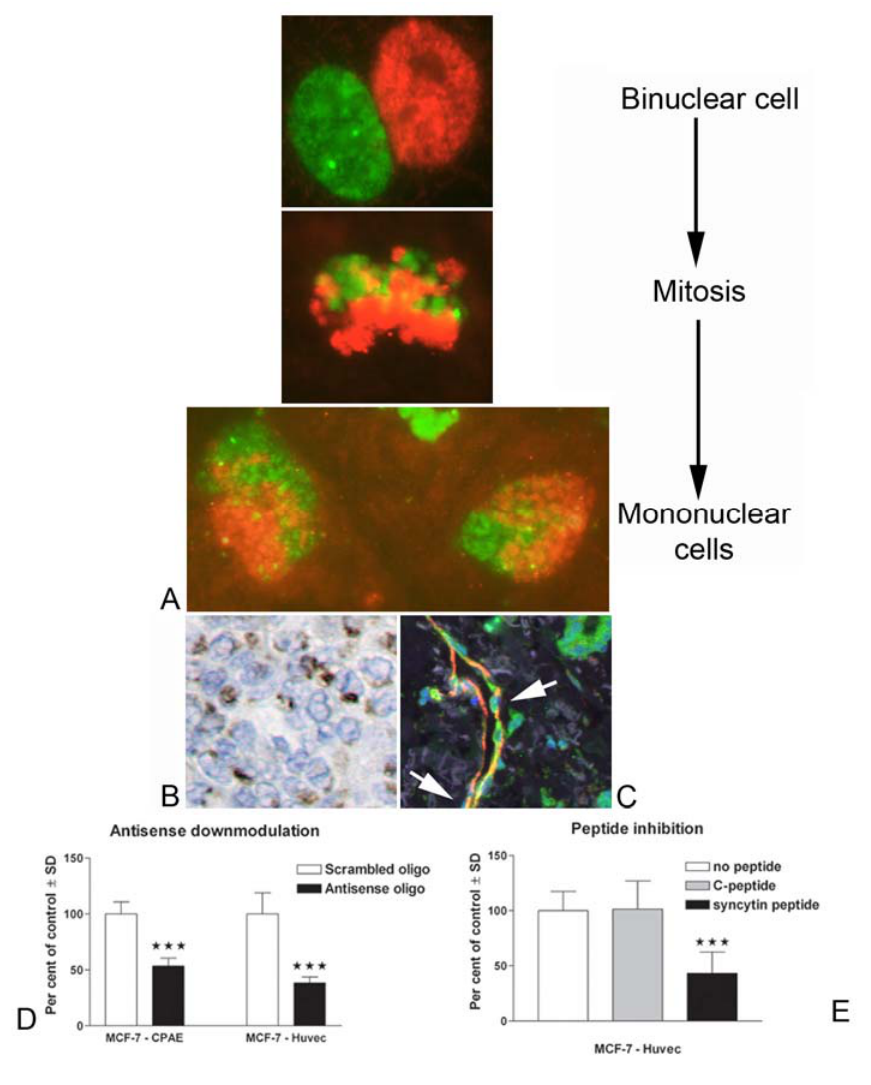
FIGURE 1A . Hybrids formed from fusions between human breast cancer cells and bovine endothelial cells reacted with fluorescent in situ hybridization (FISH) to reveal human chromosomes in red and bovine chromosomes in green. Initially, bi- (or multi-) nuclear cells form in which the parental genomes are segregated in different nuclei. Subsequently, mitoses, containing an admixture of human and bovine chromosomes occur and mononuclear daughter cells form. Interestingly, human and bovine chromosomes occupy different domains within these nuclei. B. Immunoperoxidase staining for syncytin-1 is present in numerous cancer cells in a ductal breast cancer. C . Double-staining for ASCT- 2 (green immunofluorescence) and the endothelial cell marker CD31 (red immunofluorescence) in a breast cancer specimen shows colocalization in endothelial cells (arrows). In addition, ASCT2 expression is seen in adjacent tumor cells (green). D. Downmodulation of syncytin expression significantly decreases fusions between breast cancer (MCF-7) and bovine (CPAE) or human (HUVEC) endothelial cells. E. A syncytin inhibitory peptide significantly decreases fusions between human breast cancer cells and endothelial cells, whilst a control peptide has no